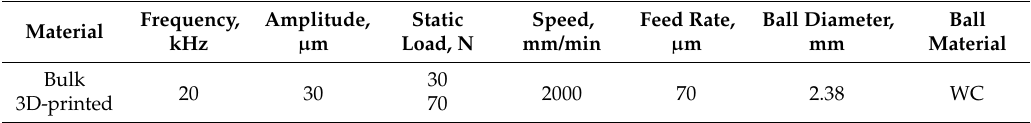
Table 3. Optimized ultrasonic nanocrystalline surface modification (UNSM) treatment parameters for bulk and 3D-printed AISI H13 tool steel.